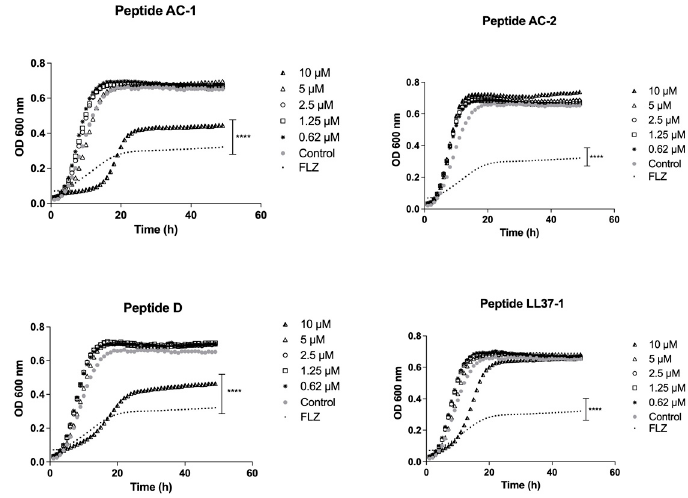
Figure 3. Growth curves of C. albicans SC 5314. Four LL-37 analogue peptides (AC-1, AC-2, D, and LL37-1) were tested at different concentrations (10, 5, 2.5, 1.25, and 0.62 µM). C. albicans SC 5314 cells without exposure to antimicrobial peptides were used as a control. Fluconazole (64 µg/mL) was used as antifungal control. Data represent three independent experiments. Statistical significance **** p < 0.0001 when compared to control.